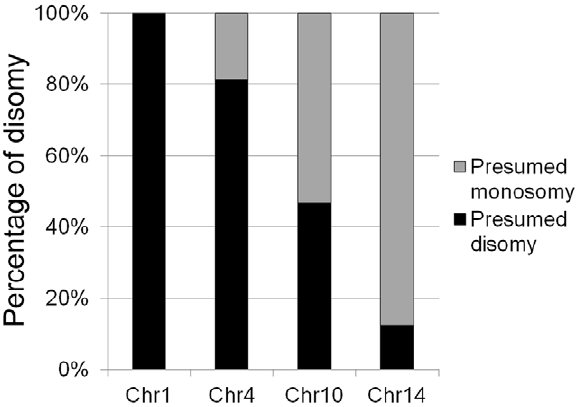
Figure 1. Chr4 disomy is associated with survival of C. neoformans at high concentrations of FLC. 16 resistant clones grown at 128 m g/ml FLC (3LHF) were randomly selected and the numbers of each chromosome in the genome were estimated by measuring the copy number of the genes specific to each chromosome. The histogram displays the percentage of presumed disomy for each chromosome in the 16 clones.